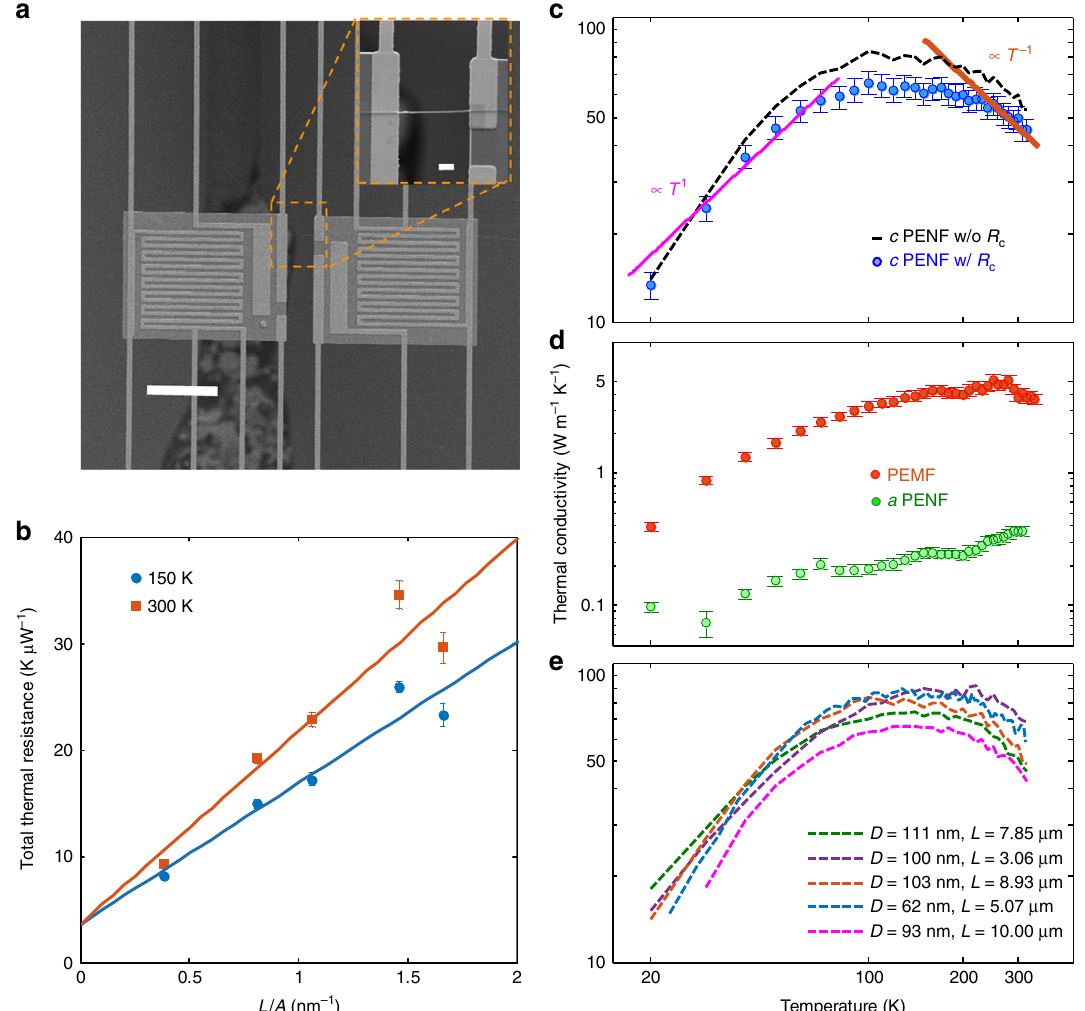
Fig. 3 Thermal characterization of PENF. a A PRT based micro-device with the heating and the sensing islands. Inset shows a PENF bridging the islands. b Total measured thermal resistance vs. L / A of crystalline ( c ) PENFs at 150 K and 300 K where the y -intercept represents 2 R c . The error bars show the mean and standard deviation values of 250 measurements. c k ( T ) of a PENF. Blue circles are measured k of a c -PENF, black dotted lines are after adjusting for 2 R c . Orange line is 1/ T trend of c -PENF at high temperatures and pink line is T 1 trend at low temperatures. The error bars are obtained using error propagation in 2 R c and measured diameter (see Supplementary Note 4 for detailed uncertainty analysis). d k ( T ) of PEMF and amorphous ( a ) PENF. Red circles are PEMF before local drawing, and green circles are c -PENF amorphized due to exposure to FIB. e k ( T ) of all reported samples after adjusted for 2 R c . Scale bars, 20 µ m and 2 µ m